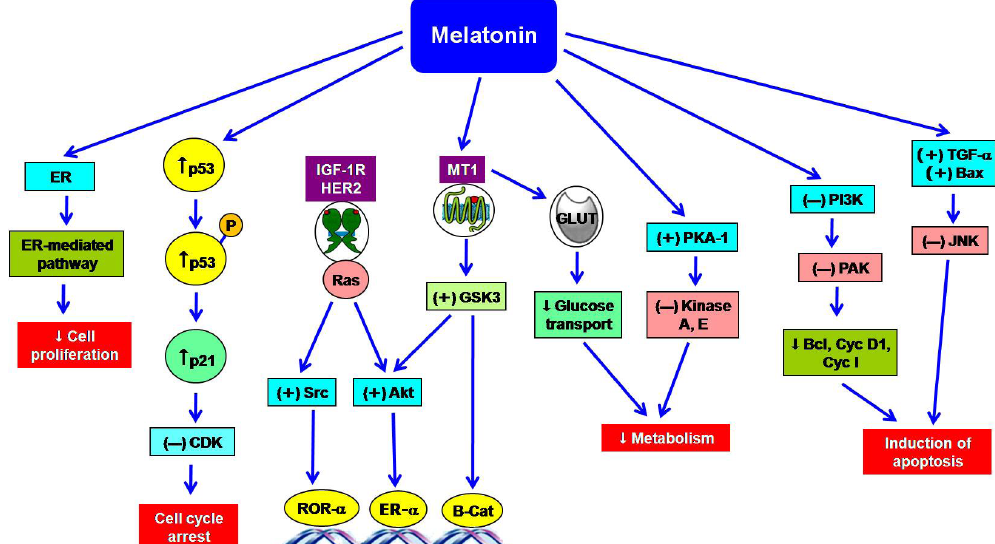
Figure 2. The multiple actions of melatonin in the prevention of breast cancer. ↑: increase; ↓: decrease; (+): stimulation; (–): inhibition; Akt: protein kinase B; Bax: B-cell lymphoma-2 associated X protein; Bcl: B-cell lymphoma; Β-Cat: beta catenin; CDK: cyclin dependent kinase; Cyc I: cyclin I; Cyc D1: cyclin D1; GLUT: glucose transporter; GSK3: glycogen synthase kinase 3; HER2: human epidermal growth factor receptor 2; IGF-1R: insulin like growth factor 1 receptor; JNK: Jun N-terminal kinase; P: protein; PAK: p21 activating kinase; PI3K: phosphoinositide 3-kinase; Ras: rat sarcoma virus; Src: sarcoma; TGF: transforming growth